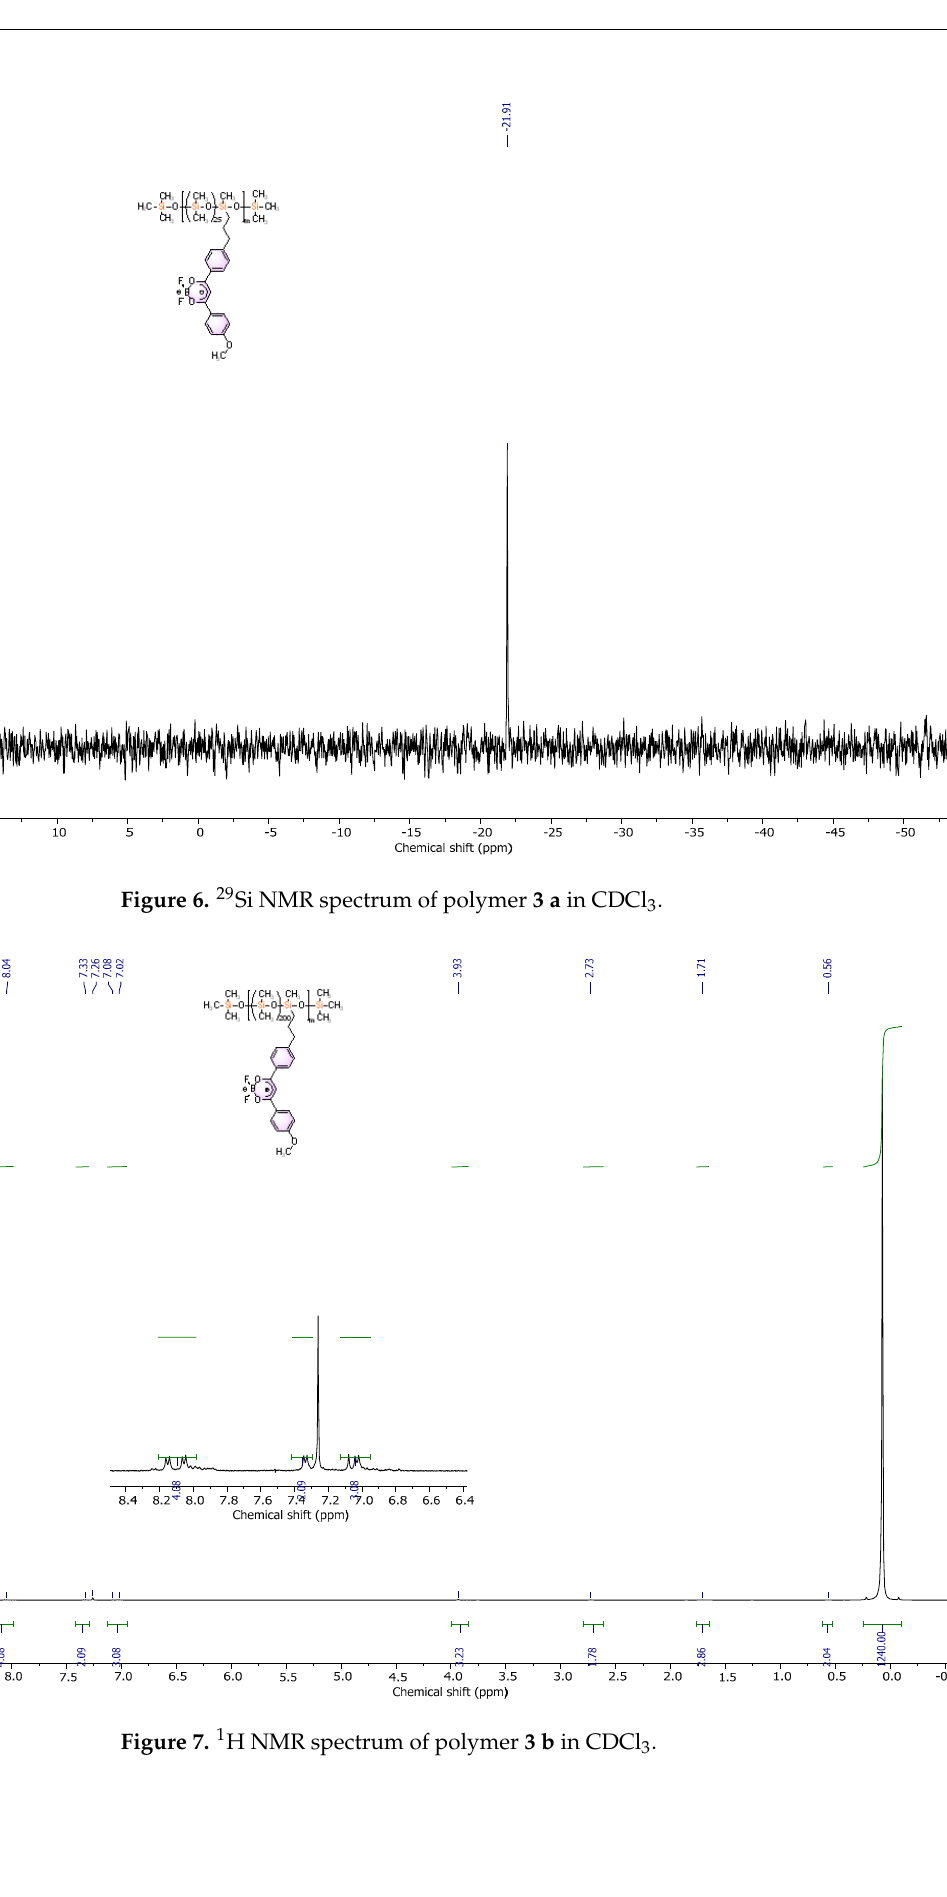
Figure 8. 13 C NMR spectrum of polymer 3 b in CDCl 3 .